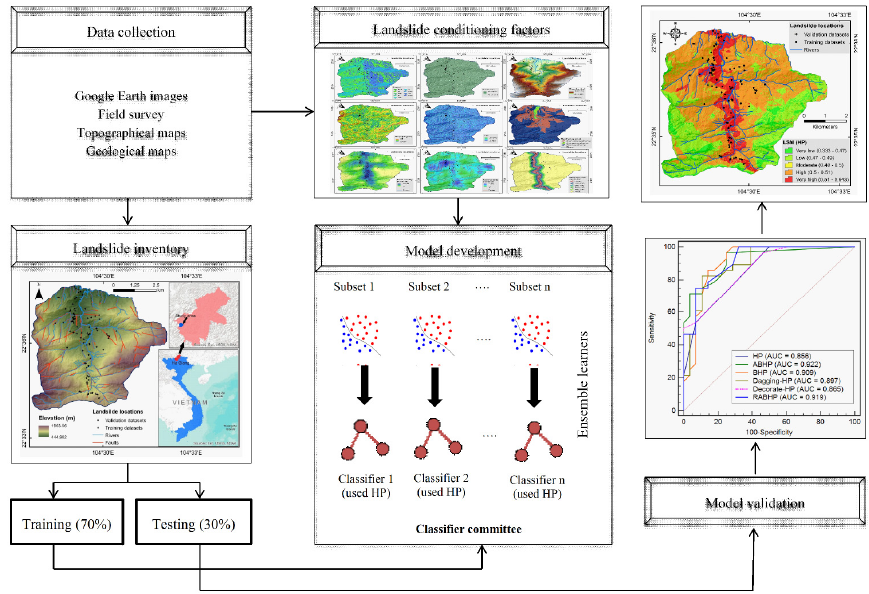
Figure 2. Flowchart of the modeling methodology proposed for the Nam Dan